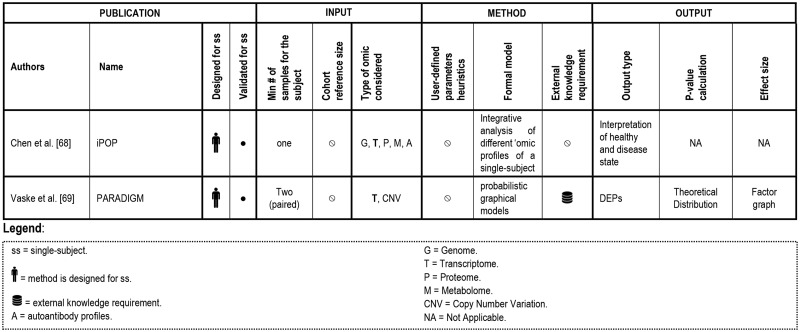
Summary of single-subject methods that analyze transcriptome data combined with other -omics.